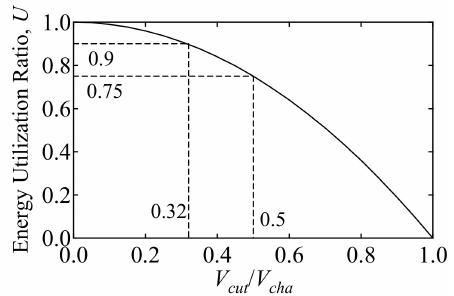
Figure 2. Energy utilization ratio of EDLC as a function of ratio of cut-o ff voltage to charge voltage ( V cut / V cha